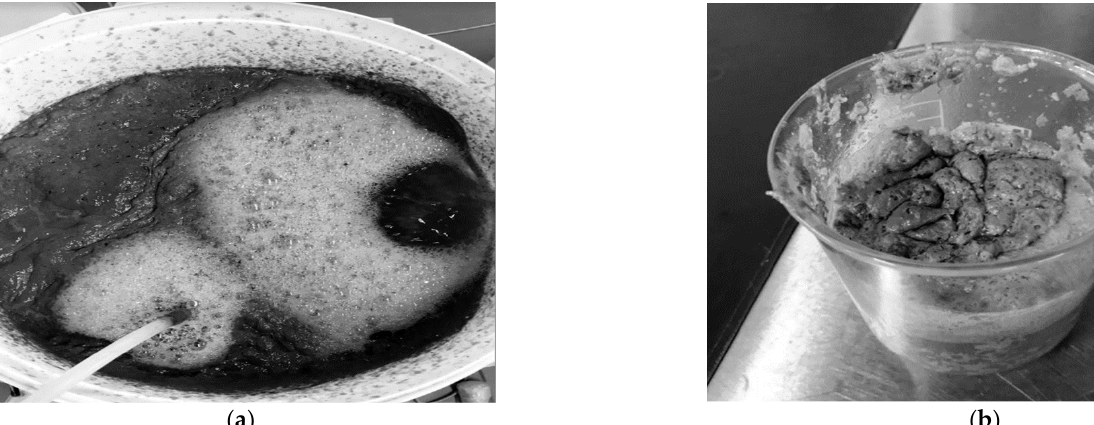
Figure 7. Performance of PSW pre-treatment stage before outliers’ detection and replacement.